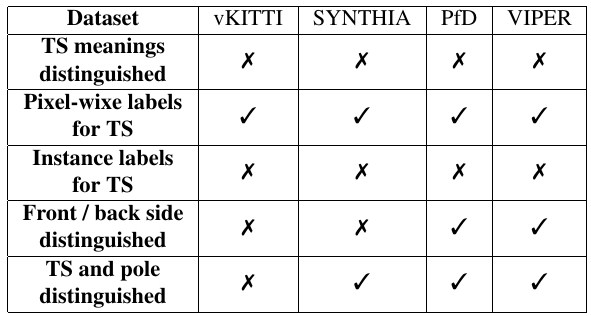
Table 2. Comparison of labeling strategies used for the analyzed synthetic image datasets with regard to traffic signs (TS).